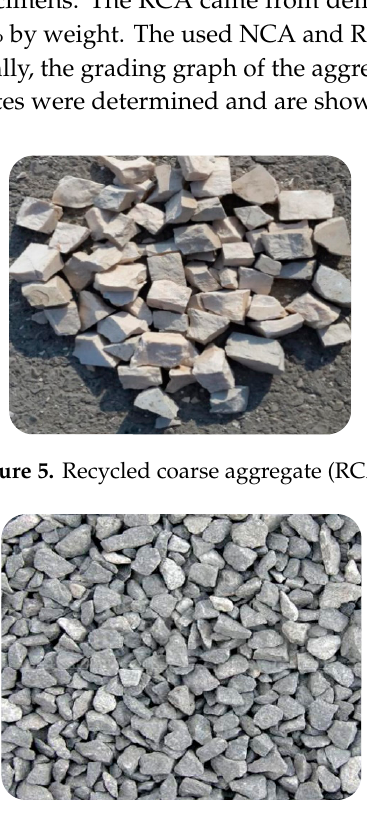
Appl. Sci. 2020 , 10 , x FOR PEER REVIEW Figure 6. Natural coarse aggregate (NCA). Figure 6. Natural coarse aggregate (NCA). Figure 6. Natural coarse aggregate (NCA).